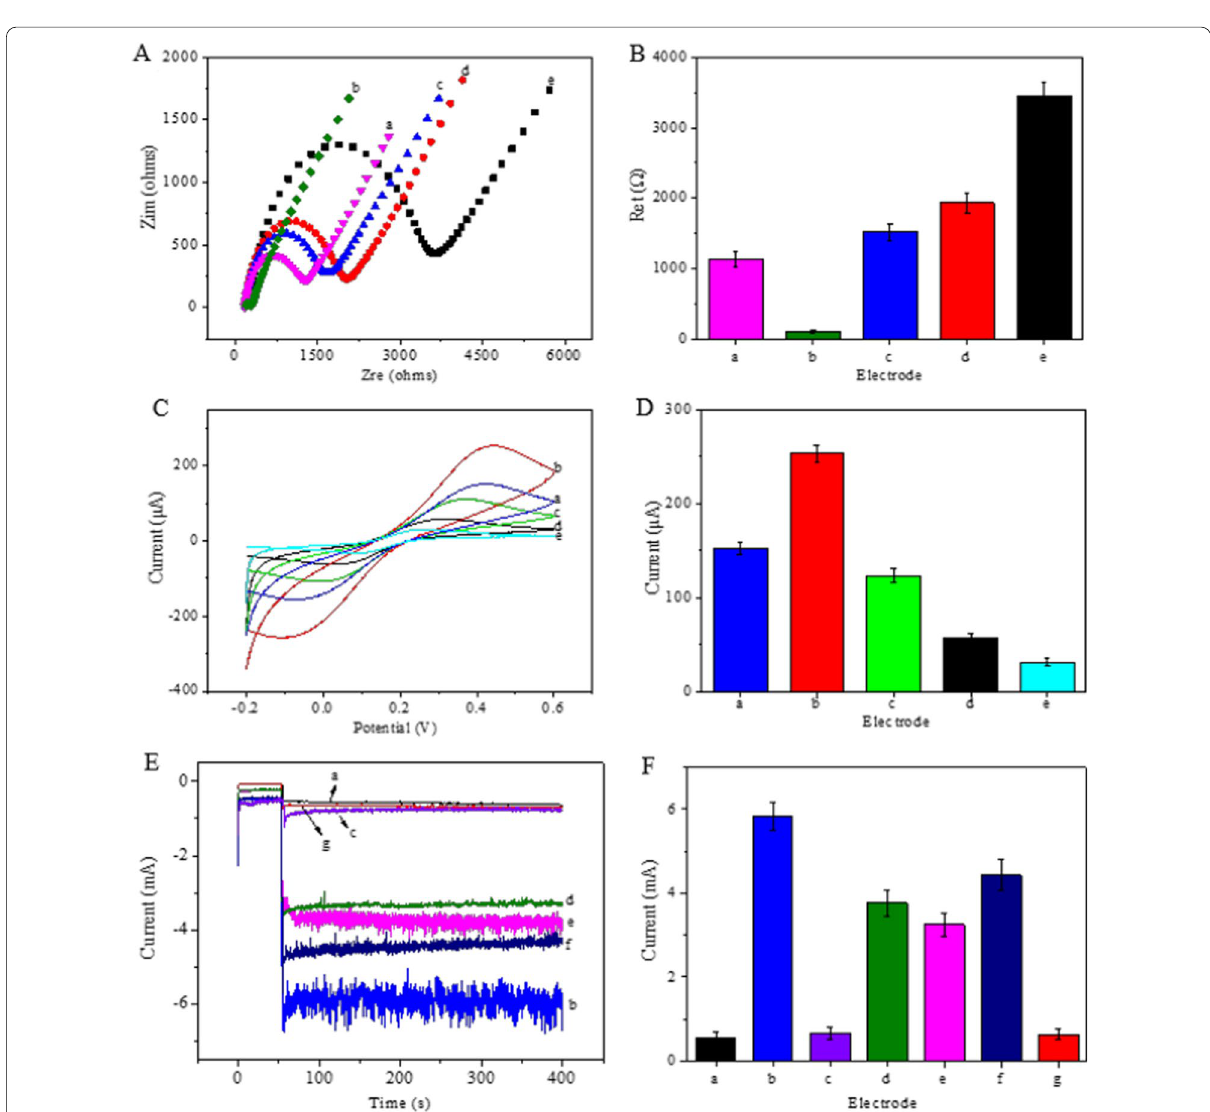
Fig. 3 A Nyquist plots and B the R et (error bar RSD, n 5) obtained from the EIS characterization of electrodes at different modification steps = = in electrolyte (pH 7.0) containing 5 mM [Fe(CN) 6 ] 3 − /4 − : (a) GCE, (b) GS-Chi-GCE, (c) AIV H9/MAbs-GS-Chi-GCE, (d) BSA-AIV H9/MAbs-GS-Chi-GCE, (e) AIV H9-BSA-AIV H9/MAbs-GS-Chi-GCE. C and D CV of (a) GCE, (b) GS-Chi-GCE, (c) AIV H9/MAbs-GS-Chi-GCE, (d) BSA-AIV H9/MAbs-GS-Chi-GCE and (e) AIV H9-BSA-AIV H9/MAbs-GS-Chi-GCE. The scan rate was 50 mV s − 1 . E and F Amperometric i–t curves and measured responses of the immunosensor for the detection of 10 6.37 EID 50 /mL AIV H9 (a) without labels; (b) with GS-Chi-Au/Pt-AIV H9/PAbs, (c) GS-Chi-AIV H9/PAbs, (d) GS-Chi-Au-AIV H9/PAbs, (e) Chi-Au/Pt-AIV H9/PAbs and (f) GS-Chi-Au/Pt-AIV H9/PAbs as labels; and (g) without incubation with AIV H9 but with GS-Chi-Au/Pt-AIV H9/PAbs as labels at 0.4 V towards the reduction of 10 mM H 2 O 2 in electrolyte at pH −